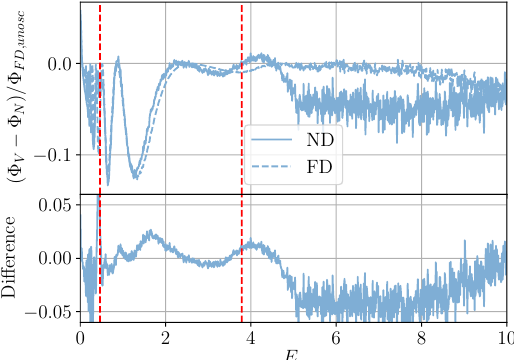
Figure 110. Cancellation of hadron production systematic variation. The top plot shows the difference between the systematically varied and nominal flux (FD) and the flux formed from the linearly combined ND fluxes. The bottom plot shows the cancellation achieved as the two variations affect the target flux and the combination flux in the same way. Note that the red dashed lines indicate the region where the target flux is fit.